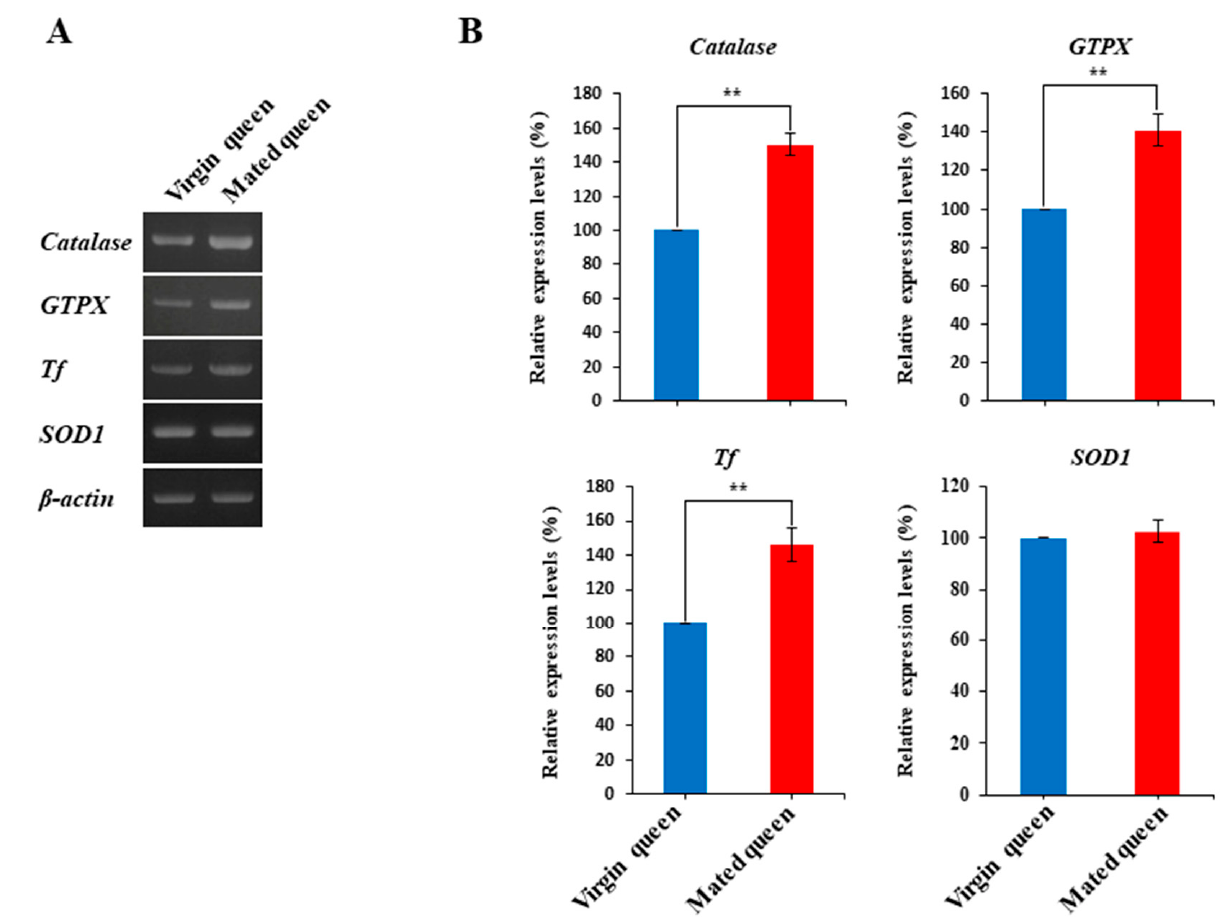
Figure 2. Transcript levels of genes encoding antioxidant proteins in the spermathecae of virgin and mated queens. ( A ) The transcripts of the antioxidant proteins catalase , GTPX , Tf , and SOD1 in the spermathecae of virgin and mated queens were quantified using RT-PCR. β -Actin was used as the internal control. ( B ) The mRNA levels are shown relative to their levels in the spermathecae of virgin queens (shown as 100%). The bars represent the mean ± SD values. Significant differences ( p < 0.01) are indicated with two asterisks.